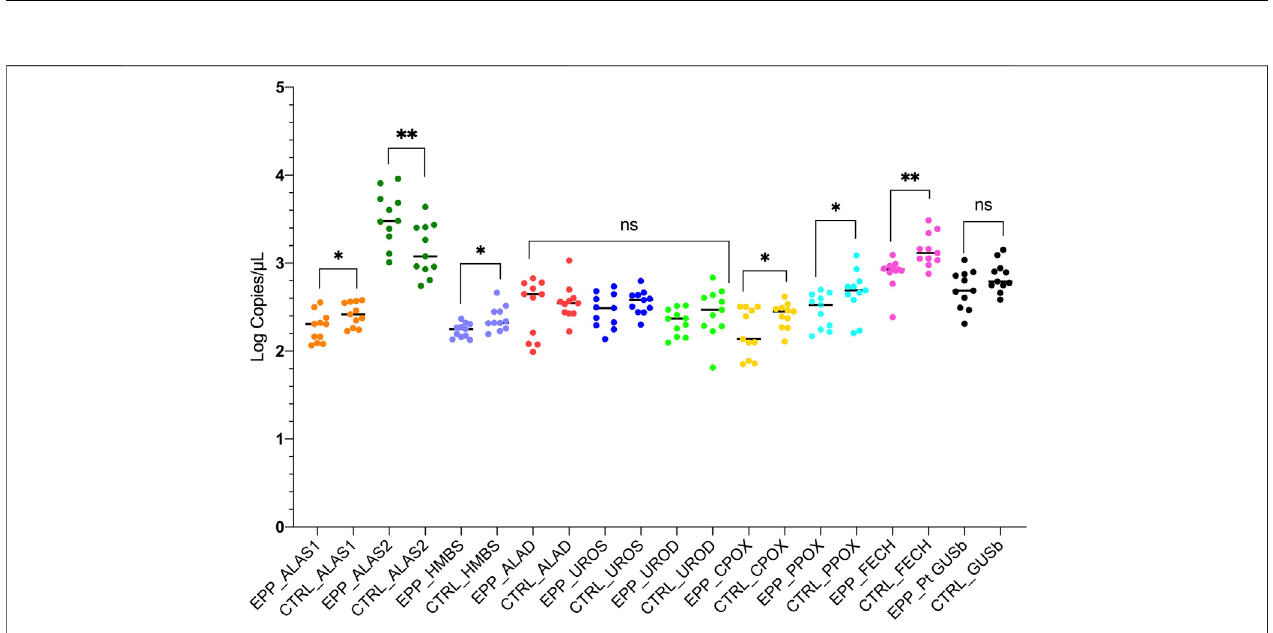
FIGURE 4 | The graph reports the results of the experiments for both patients and controls in accordance to the heme biosynthetic pathway. Statistically signi fi cances are reported and each gene is labeled with a different color. ( p * < 0.05 ** p ≤ 0.01; ns = not signi fi cant).